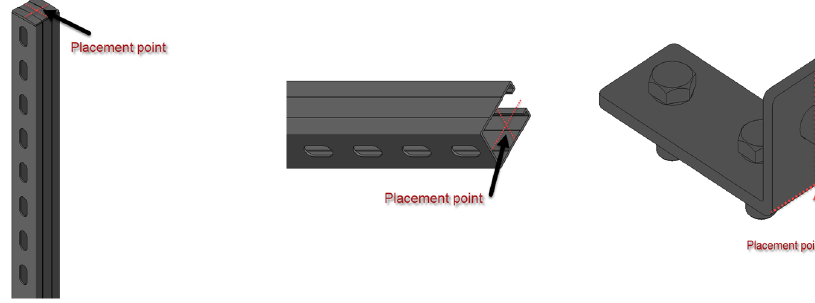
Figure 5. Family models of hanger components.